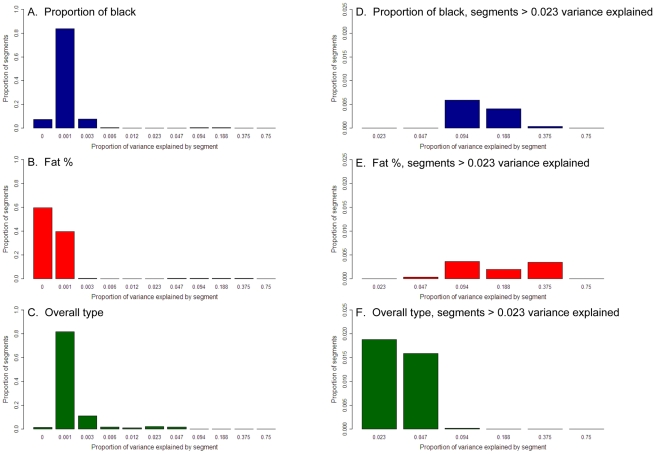
Distribution of proportion of variance explained by 50 SNP chromosome segments for three traits.Proportion of black (A), fat % (B), and overall type (C). The x axis is on a logarithmic scale. (D-F) are extreme right hand side of the same graphs, with the x axis from 0.023 to 1.0 proportion of variance explained.